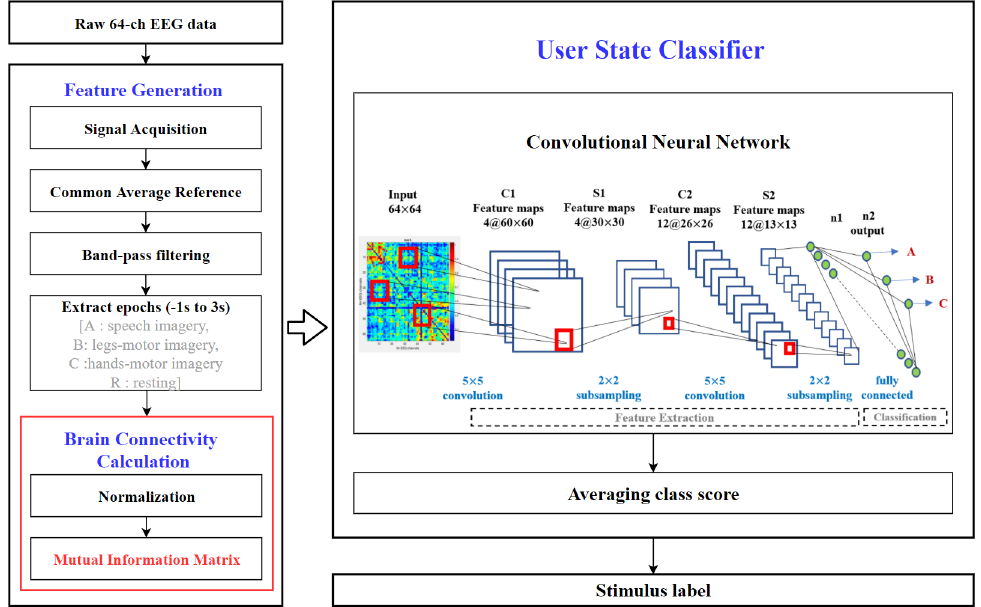
Figure 3. Proposed system architecture for user state